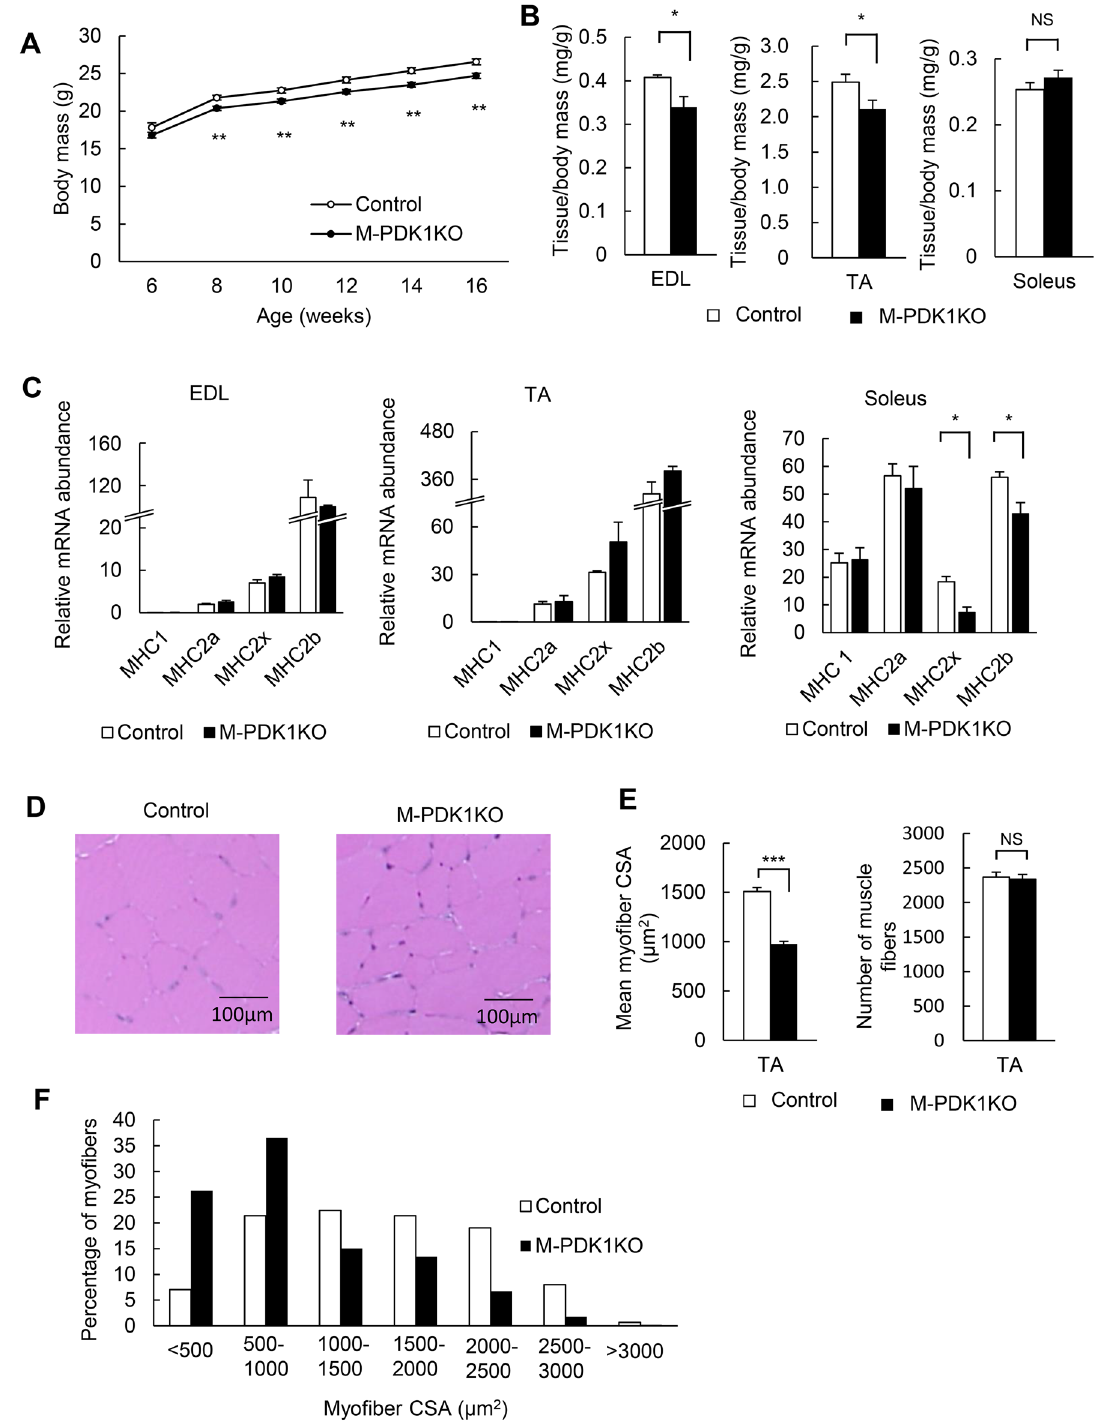
Figure 2. Reduced skeletal muscle mass in M-PDK1KO mice. ( A , B ) Body mass at the indicated ages ( A ) and skeletal muscle mass at 12 weeks of age ( B ) for control and M-PDK1KO mice [ n = 12 and 14, respectively, in ( A ); n = 8 each in ( B )]. ( C ) Quantitative RT-PCR analysis of MHC mRNAs in skeletal muscles of control and M-PDK1KO mice ( n = 4 each) at 12 weeks of age. ( D–F ) Representative hematoxylin–eosin staining ( D ) as well as the cross-sectional area (CSA) and number of muscle fibers ( E ) and the size distribution of muscle fibers ( F ) in the TA muscle of control and M-PDK1KO mice at 12 weeks of age. For the left panel of ( E ) and for ( F ), 500 fibers from four mice of each genotype were examined; for the right panel of ( E ), the number of fibers in whole cross-sections from four mice of each genotype was counted with the use of ImageJ (https ://image j.nih.gov/ ij/). Scale bars in ( D ), 100 μm. Quantitative data are means ± SEM, with the exception of those in ( F ). * P < 0.05, ** P < 0.01, *** P < 0.001, NS, not significant [One-way ANOVA followed by Tukey in ( A ) and Student’s t test in ( B , C , E